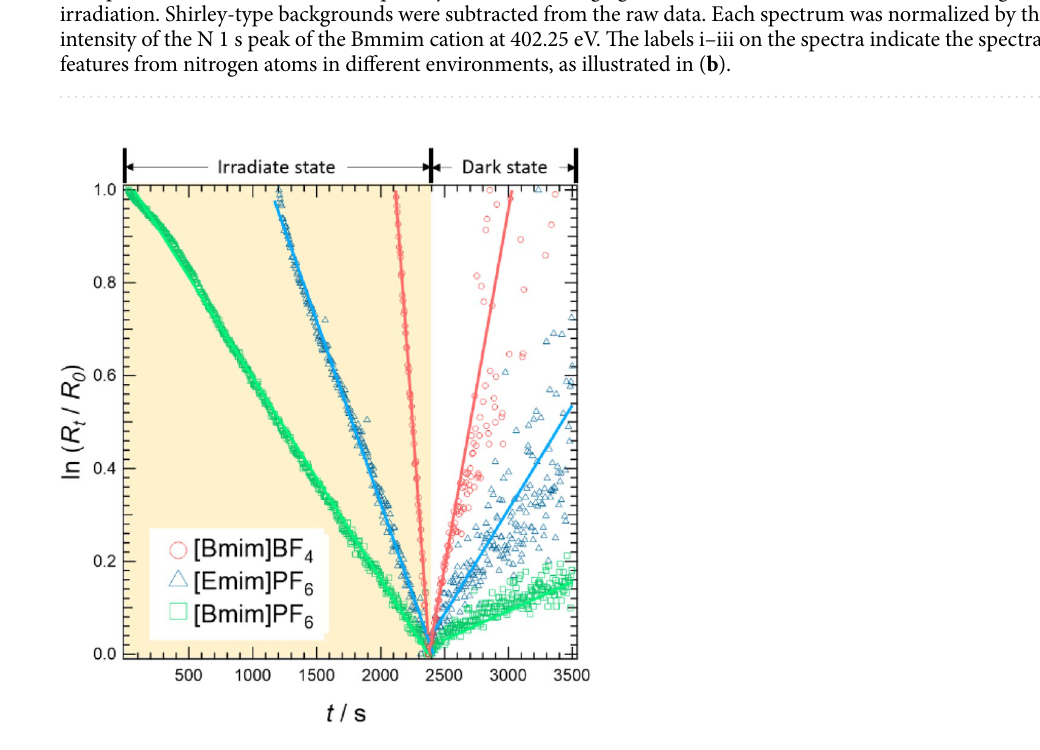
equilibrium between PHIG[yellow] and PHIG[blue] in the dark state, that light irradiation triggers the system towards a new equilibrium position, and relaxation to the original equilibrium position occurs when irradiation is terminated. This transfer between two equilibrium states is described as follows: